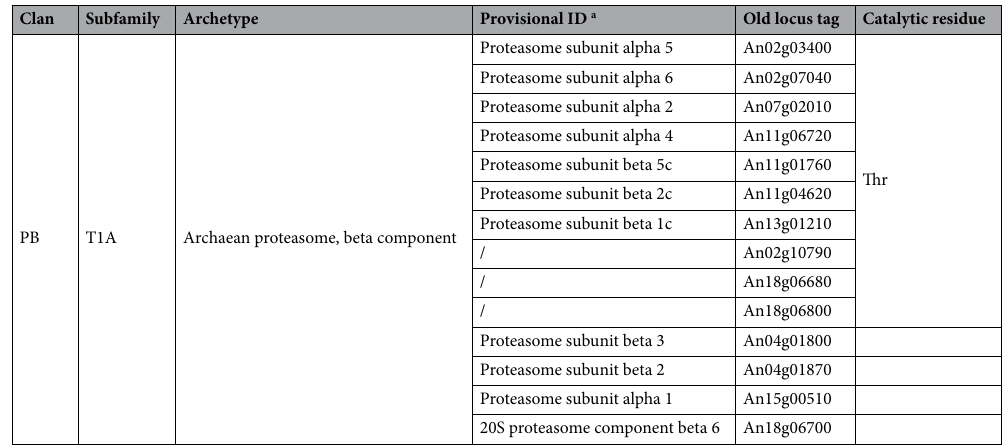
Table 4. Threonine proteases encoded by A. niger strains CBS 513.88 and ATCC 1015. a /, not provisionally